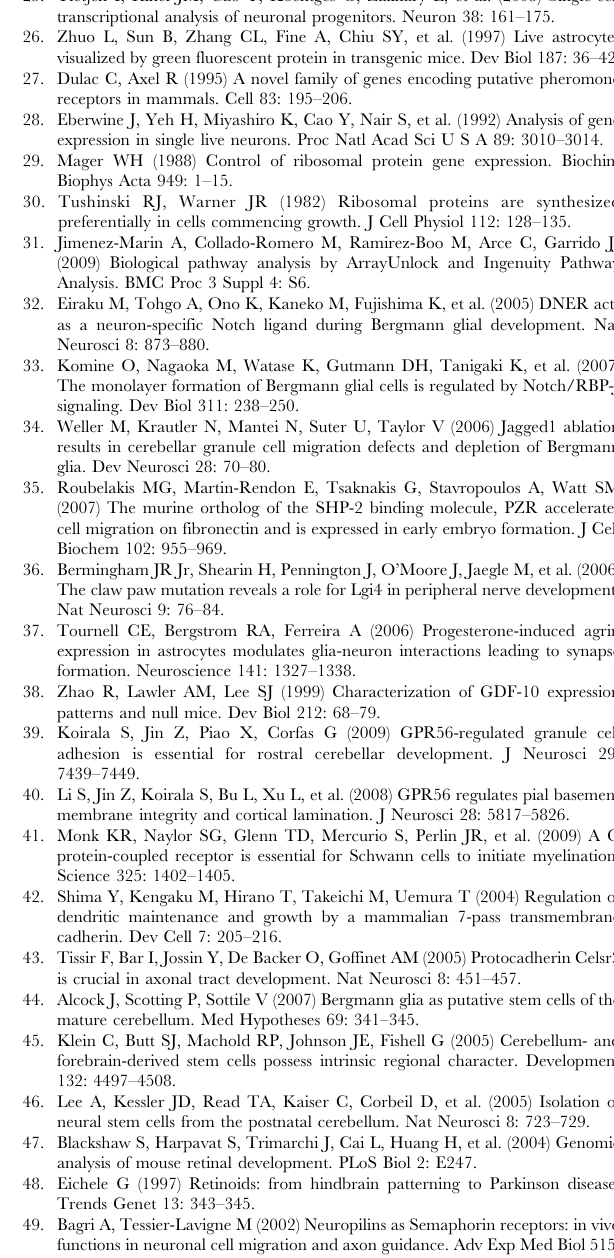
Figure S3 Expression patterns of well established astroglial markers in the adult cerebellum. Mid-sagittal views of adult mouse cerebella with in situ hybridization images (left panels) and expression level analysis (right panels), as obtained from the Allen Brain Atlas. Insets in all images are from the dorso-rostral region of lobule V as in Fig. S1. The glial genes, Slc1a3 , Fabp7 , S100 b and Sept4 are four widely used astroglial markers, and their expression in Bergmann glia (but not Purkinje cells or other cerebellar neurons) has been confirmed by previous studies. The cellular expression patterns of these genes are presented here to serve as controls against which the Bergmann glial expression of new genes